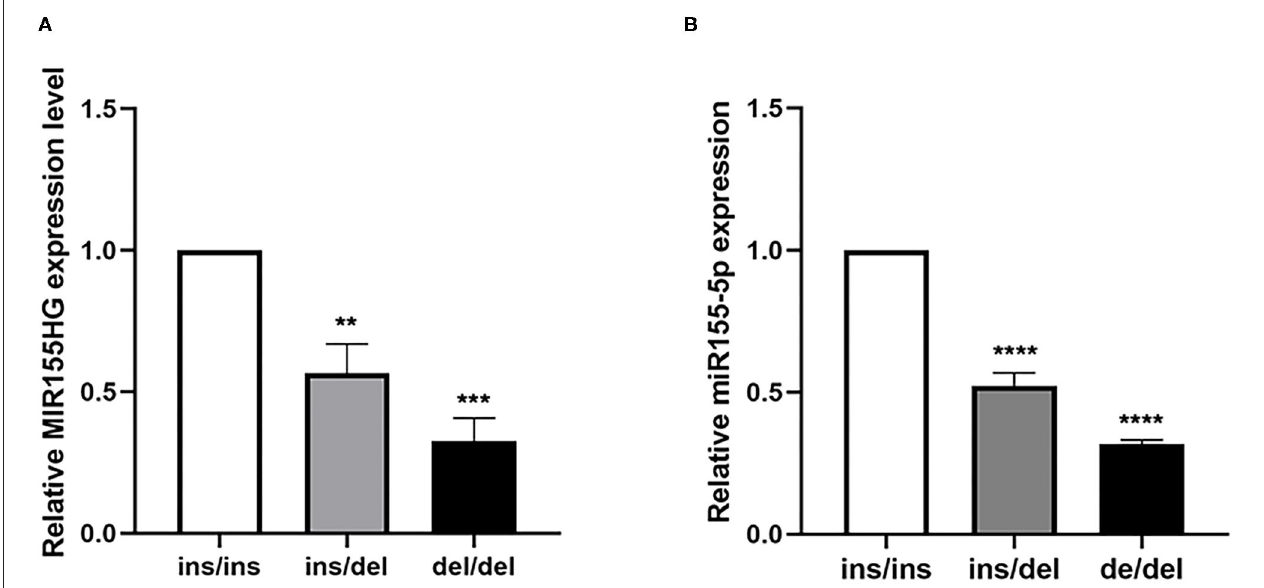
FIGURE 3 | The expression levels of MIR155HG and mature miR-155 in human myocardium tissues with different genotypes. (A) The mRNA level of MIR155HG in human samples showed that in tissues with the ins/del and del/del genotype was 0.42- and 0.68-fold lower than that in samples with ins/ins genotype (** P < 0.01, *** P < 0.001, ins/ins, N = 9, ins/del, N = 5, del/del, N = 5). (B) Mature miR-155 expression in tissues showed the same tendency as MIR155HG. Myocardium samples with the ins/del and del/del genotype was 0.48- and 0.68-fold lower than that with ins/ins samples, respectively (**** P < 0.0001, ins/ins, N = 9, ins/del, N = 5, del/del, N = 5).